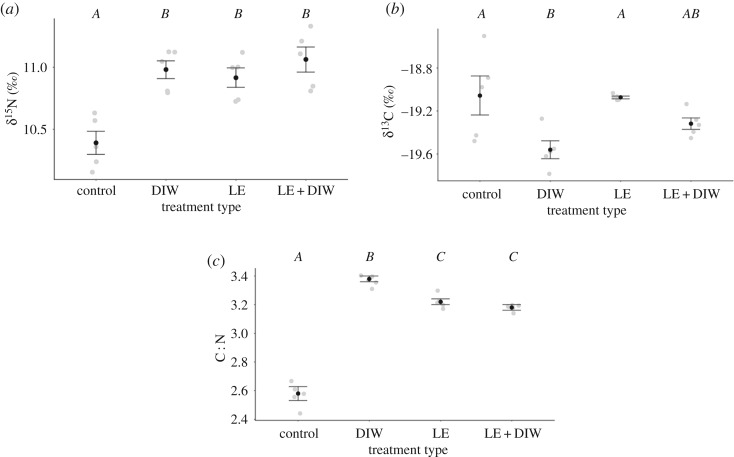
Comparison of urea and lipid extraction treatment effects on the mean values ± s.e. of δ15N (a), δ13C (b) and C : N (c) ratios of reef manta ray (Mobula alfredi) muscle tissue. Treatments with different letters are significantly different (p < 0.05). Control, untreated; DIW, urea extraction only; LE, lipid extraction only; LE + DIW, lipid and urea extraction.